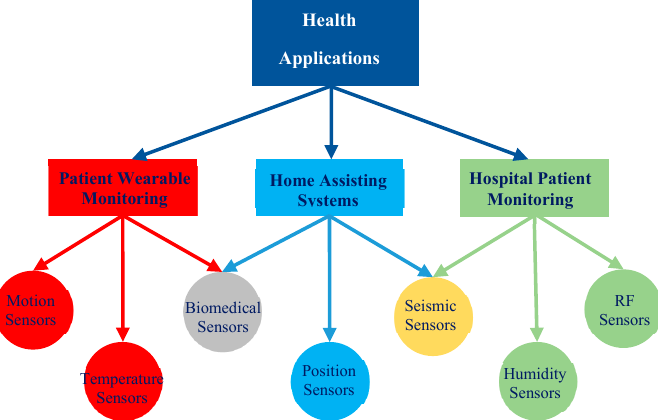
Figure 6. The subcategories of the health applications of WSNs and the sensors used in them.